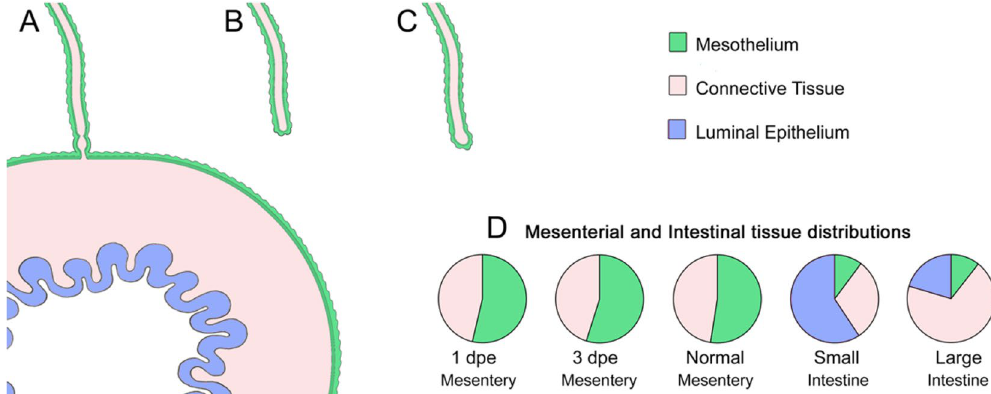
Figure 1. Diagram illustrating the intestine composition of normal and regenerating stages in H. glaberrima . ( A ) Normal intestine and attached mesentery. The other end of the mesentery (not shown) is attached to the body wall. ( B ) Mesentery one day after evisceration of the intestine. ( C ) Mesentery three days following evisceration Distribution of tissues in normal intestine and mesentery and in regenerating mesentery/intestine at 1 and 3 days post-evisceration